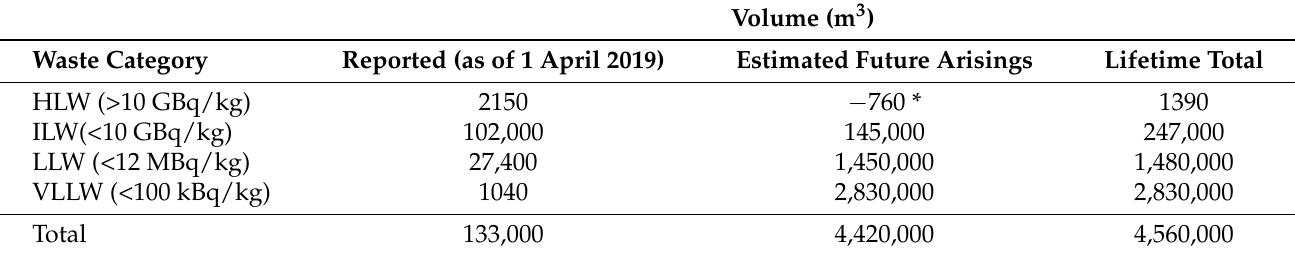
Table 1. Current, future arisings and lifetime total expected volumes of different nuclear waste categories. All values are a direct reproduction from the Nuclear Decommissioning Authority report [3]. * This negative value reflects the future conditioning of waste